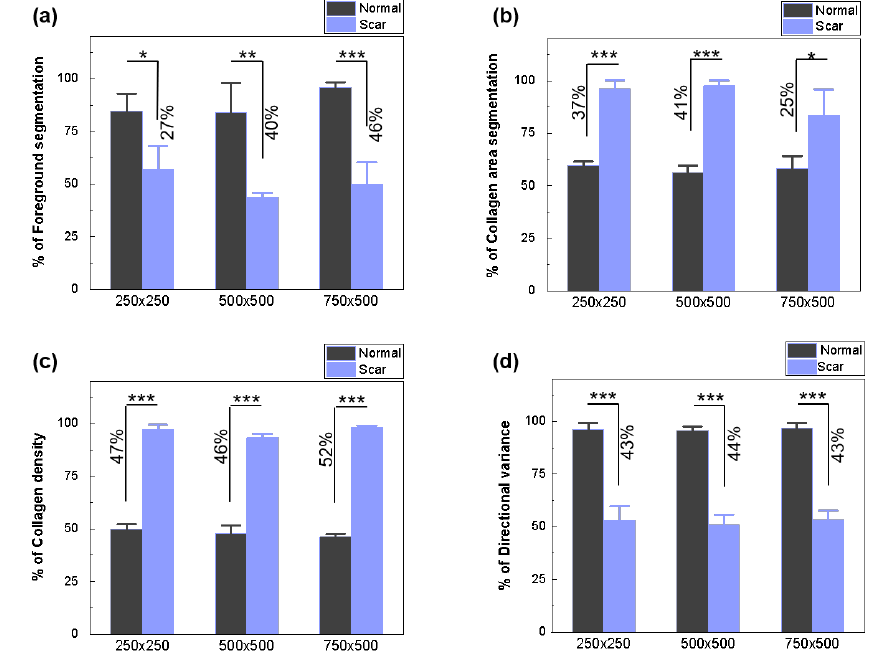
Figure 9. Statistical comparison between normal and scar tissues: ( a ) FS, ( b ) CAS, ( c ) CDM, and ( d ) di- rectional variance of collagen (* p < 0.05, ** p < 0.01, *** p <